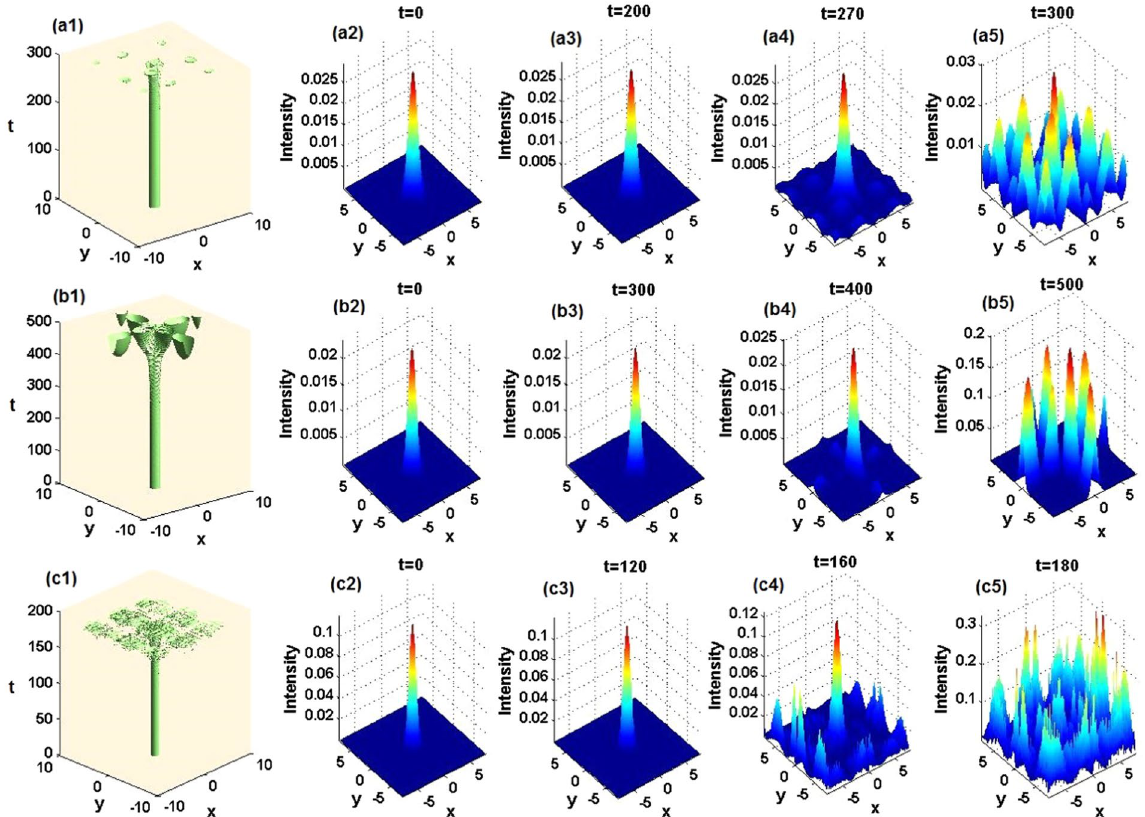
Figure 14. Unstable evolution of 2D solitons. ( a1 , b1 , c1 ) The unstable evolution of numerical found solitons corresponding to µ µ µ = . = . = . 3 4, 6 3, 11 1 for α = 1, 2, 3 , respectively. ( a2 , b2 , c2 ) The corresponding 1 2 3 initial states; ( a3 , b3 , c3 ) apparently stable intermediate states; ( a4 , b4 , c4 ) becoming-unstable intermediate states; ( a5 , b5 , c5 ) unstable final states. Note that t-axes should be z-axes in ( a1 , b1 , c1 ) and “t = ” should be “z = ” in ( a2